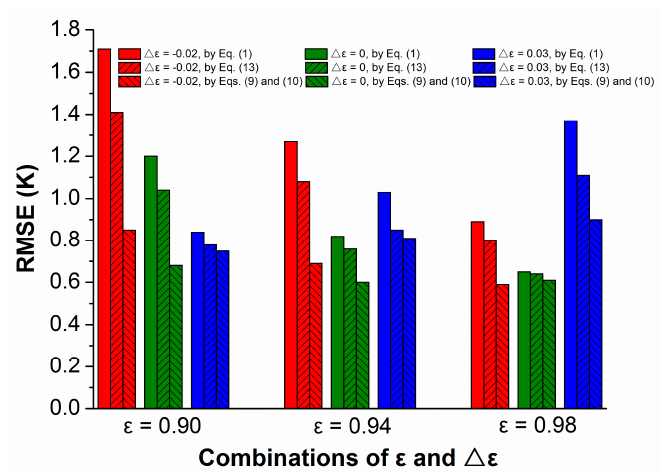
Figure 14. Comparison of RMSEs yielded by Equations (1) (9), (10) and (13) for different combinations of channel mean emissivity ( ε ) and channel emissivity difference ( Δε ).